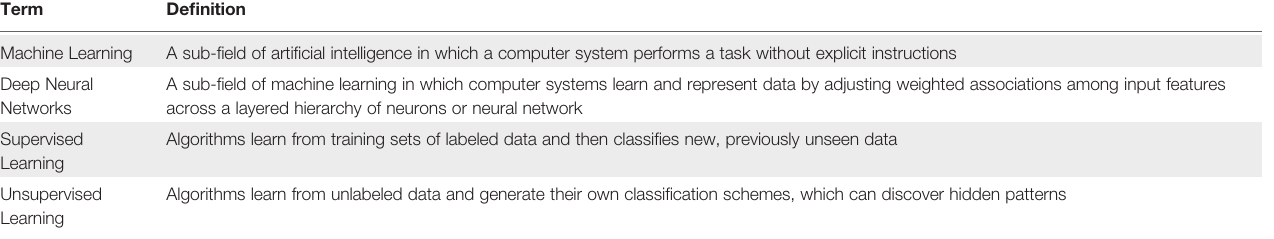
TABLE 1 | A glossary of machine learning terms and applications in solid organ